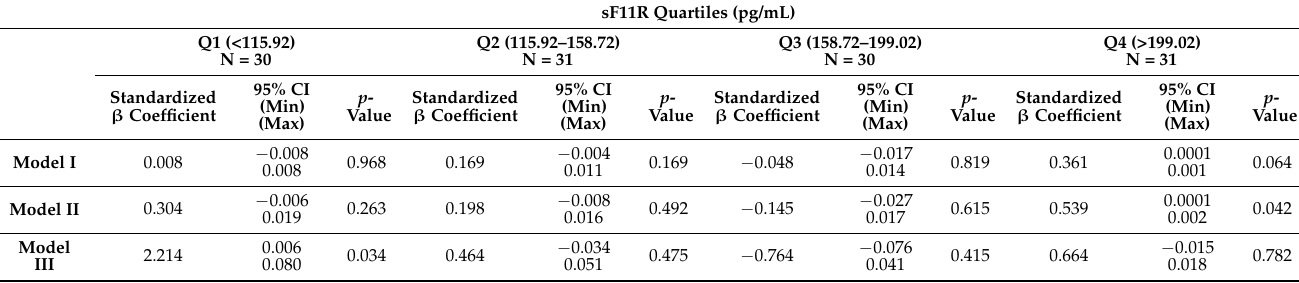
Table 5. Association between sF11R and ANXA5 according to quartiles of circulating plasma sF11R